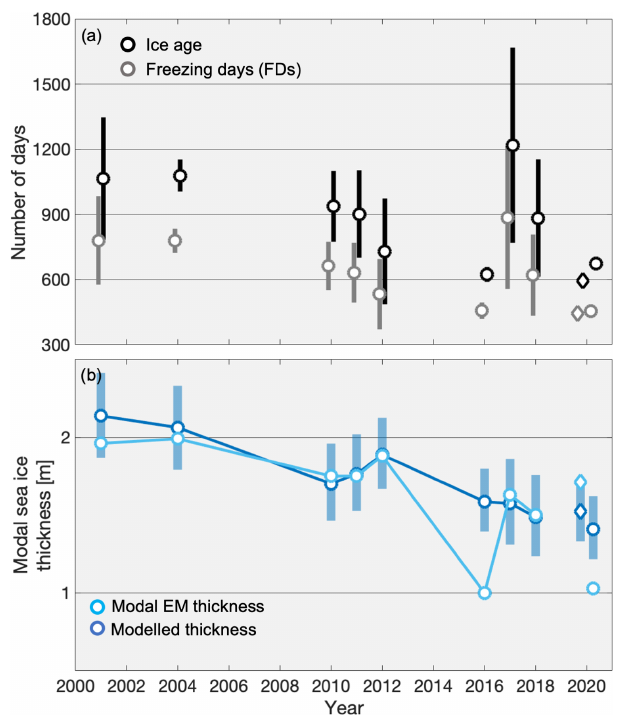
Figure 3. (a) Mean sea ice age (black) and mean number of days with surface temperatures below − 1.9 ◦ C (grey, FDs) of AOI- sampled sea ice. Error bars indicate 1 standard deviation of age and FDs for each year. (b) Modal EM SIT (light blue; see Fig. 1b) and reconstructed modal SIT from the Thorndike (1992) thermody- namic sea ice model. Error bars show maximum modelled SIT error resulting from root-mean-square errors of Warren et al. (1999) snow values. Circles indicate larger-area measurements, while diamonds show values referring to the MOSAiC